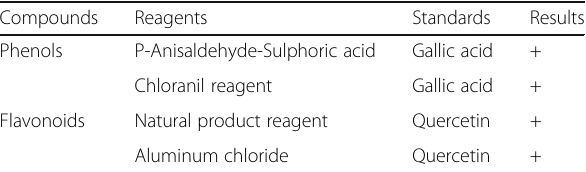
Table 1 Phytochemical result of extract